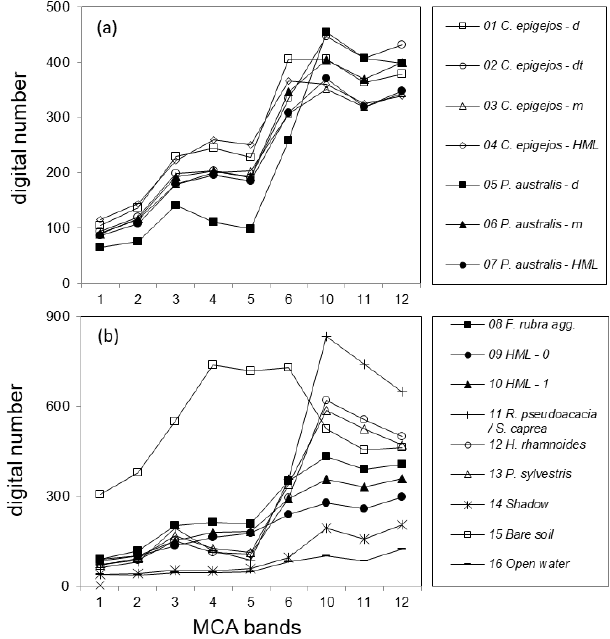
Figure 3. Mean signatures of classified LCCs other than C. epigejos and P. australis (a) and respective signatures of C. epigejos and P. australis classes (b) . Note the different scaling of the y axes.